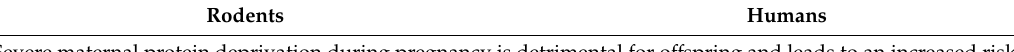
Table 3. Key points for clinical